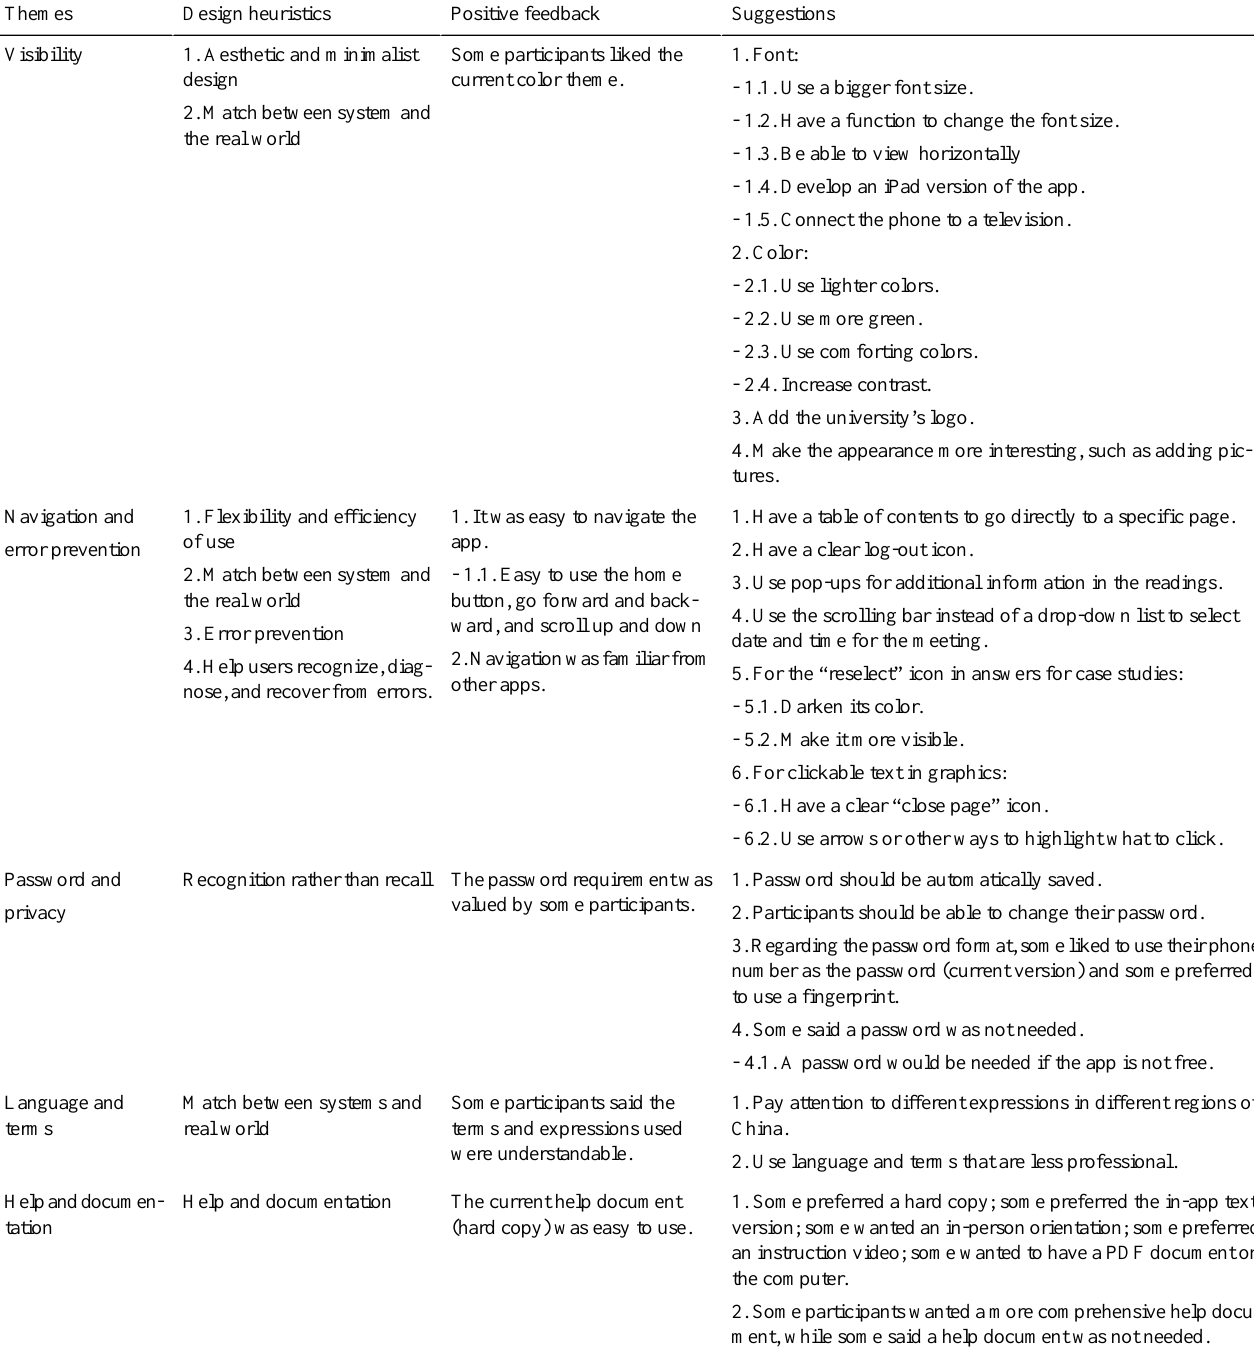
SuggestionsPositive feedbackDesign